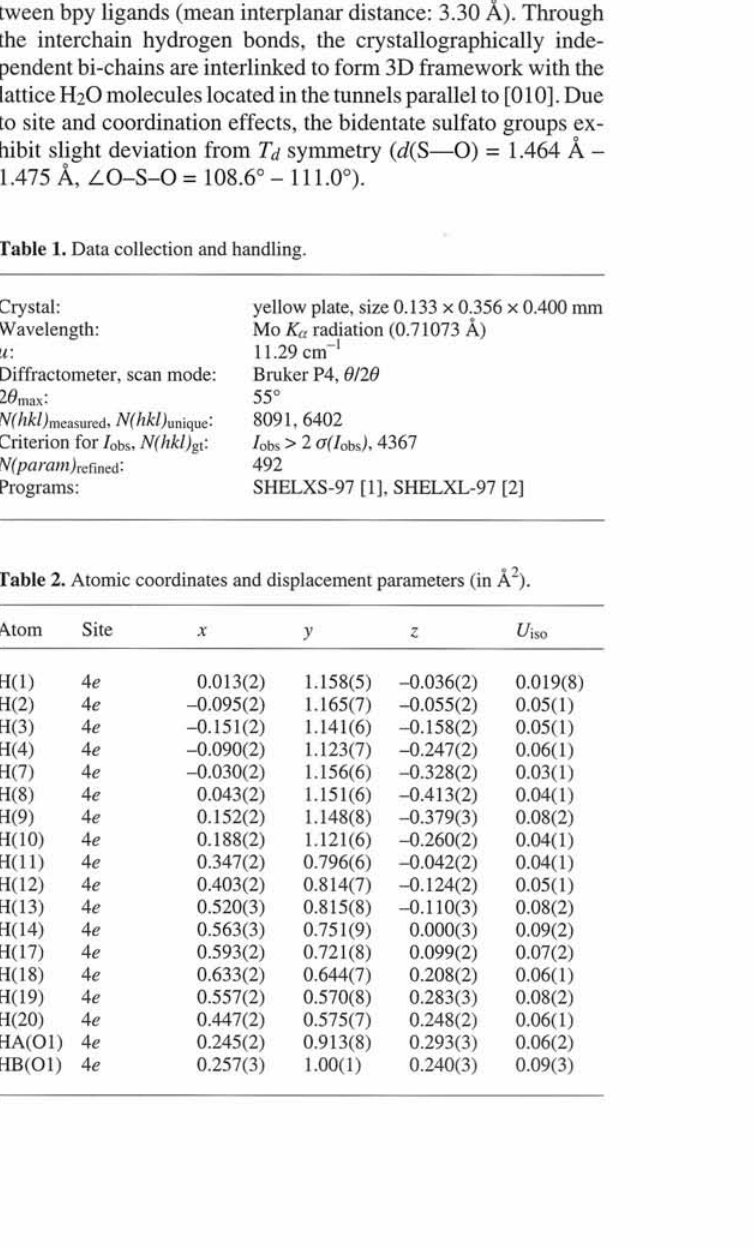
Table 1. Data collection and handling.